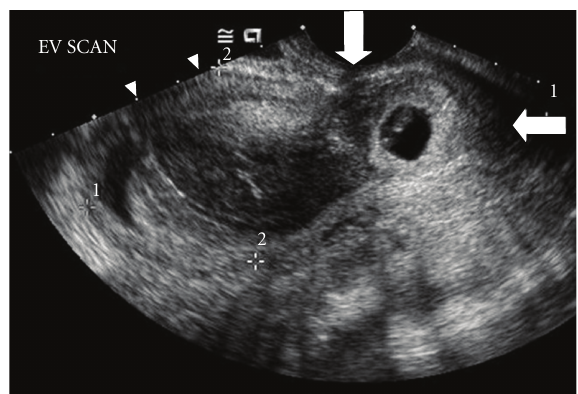
Figure 1: A gestational sac with a small embryonic pole with a fetal heartbeat of 122 bpm located in the cervix below the scar of the previous cesarean section (vertical arrow). Cervix was closed, enlarged, and tender (horizontal arrow). Estimated gestational age based on last menstrual period was 6 weeks and 6